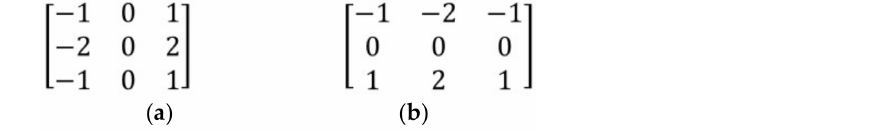
Figure 7. The horizontal and vertical templates of Sobel: ( a ) vertical templates of Sobel, ( b ) horizontal templates of